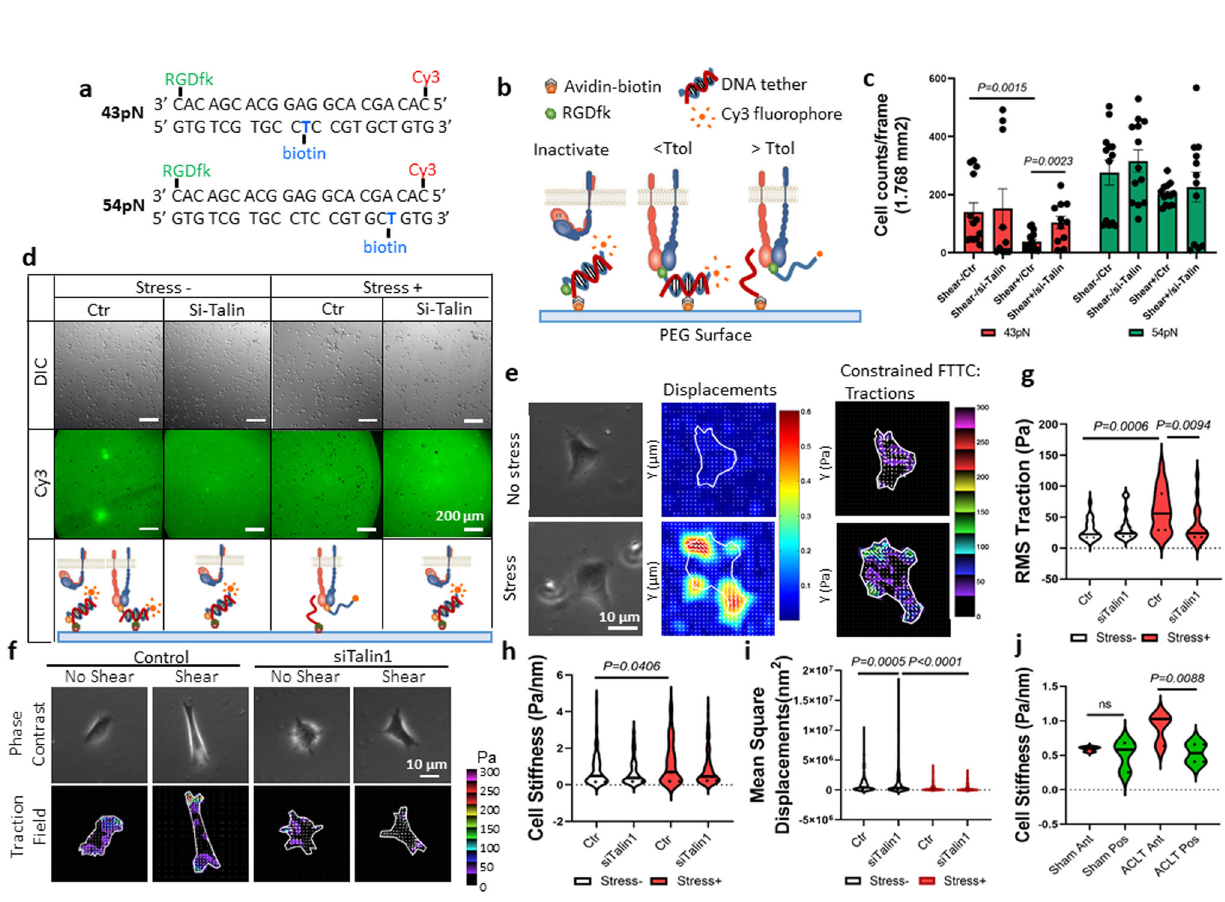
Fig. 5 Talin mediates the strengthening of α V integrin – RGD bond under mechanical stress. a The sequence of the dsDNA and the conjugation sites of speci fi c molecules. b Schematic illustration of the TGT principle. A dsDNA tether is immobilized on the PEG surface through an avidin – biotin linker. The location of the biotin determines the tension tolerance (Ttol) of the dsDNA. The integrins expressed by the cell bind to the RGDfk conjugated with the dsDNA at one end. The dsDNA ruptures if the tension applied by the cell through the integrin – RGD bond is greater than its Ttol. The Cy3 fl uorescence signals and the adhesion of the cells on the PEG surface are maintained if the tension applied by the cell through the integrin – RGD bond is lower than its Ttol. c Cell density represents the rupture of the DNA tether. n = 13 – 17 independent cells. Data are presented as mean values + / − SEM. Data were analyzed using two-tailed t test. Source data are provided as a Source data fi le. d Representative differential interference contrast (DIC) images of the SV40 cells on the PEG surface (upper row) and the direct imaging of RGDfK-dsDNA-Cy3 removal on the PEG surface (bottom row). The cells were prechallenged with or without shear stress. The quantitative analysis is shown in c . Ctr cells were treated with control siRNA, Si-Talin cells were treated with talin siRNA. e Representative phase contrast (left column), the displacement of magnetic beads (middle column), and traction map images (right column) of SV40 cells that were preconditioned with or without shear stress. White lines show the cell boundary; colors show the magnitude of the tractions in Pa (see color scale). f Representative phase contrast (upper row) and traction map images (bottom row) of SV40 cells preconditioned with or without shear stress. Ctr cells were treated with control siRNA, Si-Talin cells were treated with talin siRNA. The quantitative analysis results are shown in g – i . g – i Quantitative analysis of RMS traction force ( g ), cell stiffness ( h ), and cytoskeleton remodeling ( i ) based on the displacement of magnetic beads. n = 10 independent experiments. Data were analyzed using two-way ANOVA Turkey ’ s post hoc tests. Source data are provided as a Source data fi le. j Quantitative analysis of cell stiffness of primary chondrocytes isolated from AC of mice tibia medial compartment. The mice were sacri fi ced 1 month after ACL-T or sham surgery. Ant anterior region, Pos posterior region. n = 3 independent animals. Data were analyzed using two-way ANOVA Turkey ’ s post hoc test. Source data are provided as a Source data fi